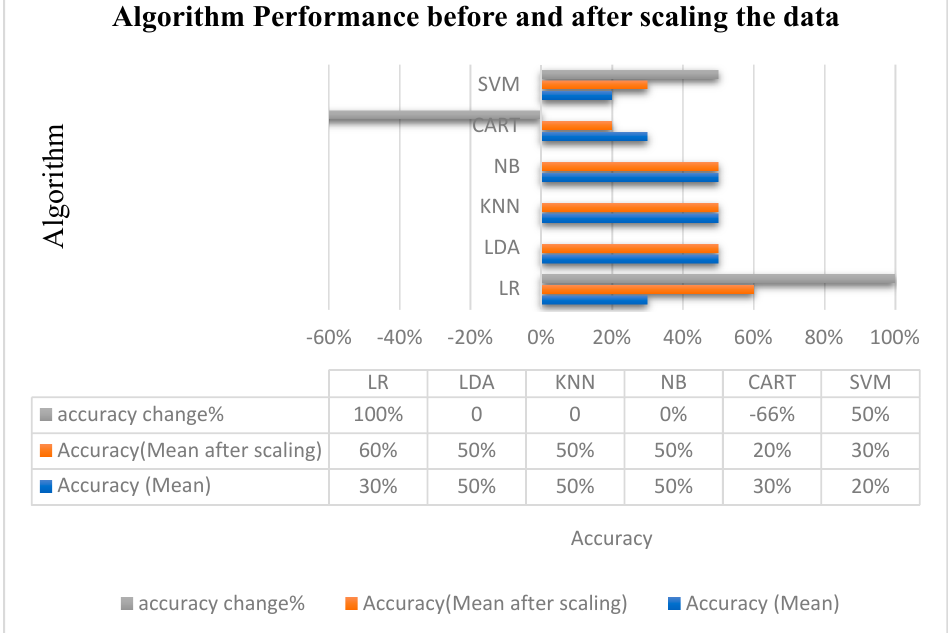
Figure 1. Algorithm performance before and after data standardization.